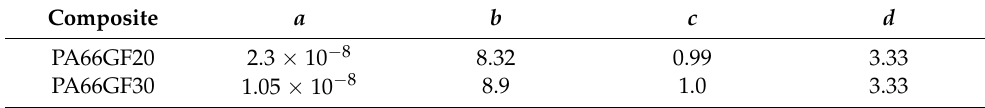
Table 5. Material parameters of the fatigue damage model for PA66GF20 and